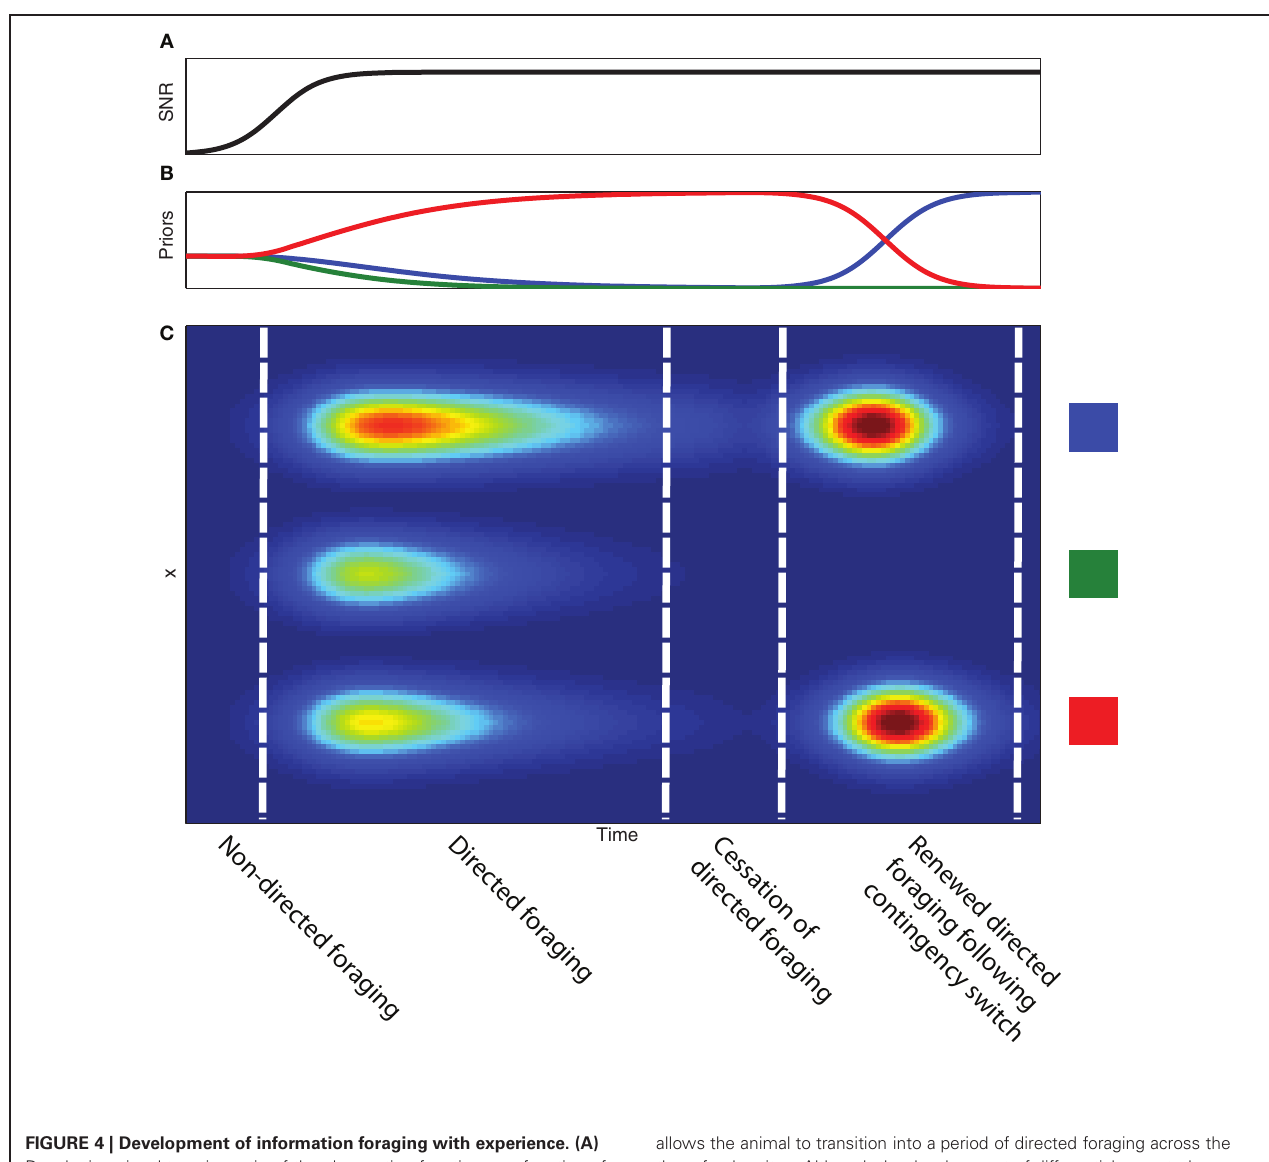
FIGURE 4 | Development of information foraging with experience. (A) Developing signal-to-noise ratio of the observation function as a function of time. (B) Developing prior probabilities as a function of time. (C) Expected information gain as a function of time (x-axis) and sample position (y-axis). Note the development of higher expected information coincides with the development of the signal-to-noise ratio of the observation functions. The uniform expected information gain suggests an initial period of non-directed or random foraging behavior. The non-uniform expected information gain